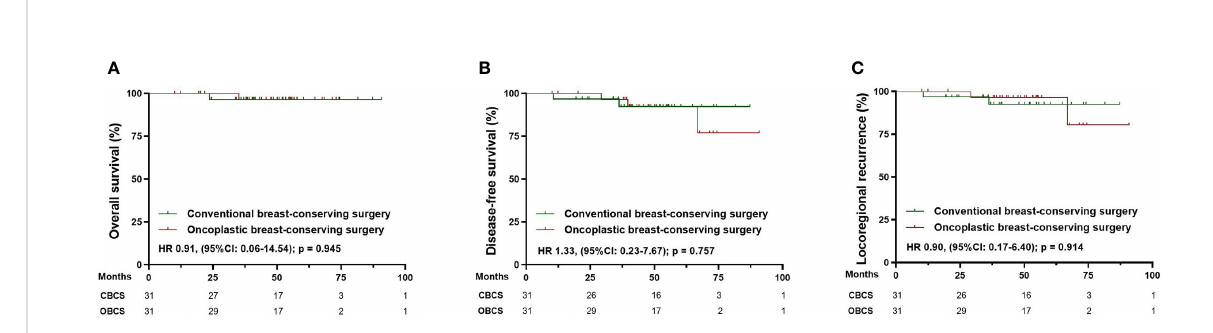
FIGURE 6 Survival analysis in the matched cohort of patients receiving conventional breast-conserving surgery (n=31) and oncoplastic breast-conserving surgery (n=31). (A) Kaplan-Meier curves for overall survival analysis in patients of different surgical groups. (B) Kaplan-Meier curves for disease- free survival analysis in patients of different surgical groups. (C) Kaplan-Meier curves for locoregional recurrence analysis in patients of different surgical groups. CBCS, conventional breast-conserving surgery; OBCS, oncoplastic breast-conserving surgery; HR, Hazard ratio; 95% CI, 95% con fi dence